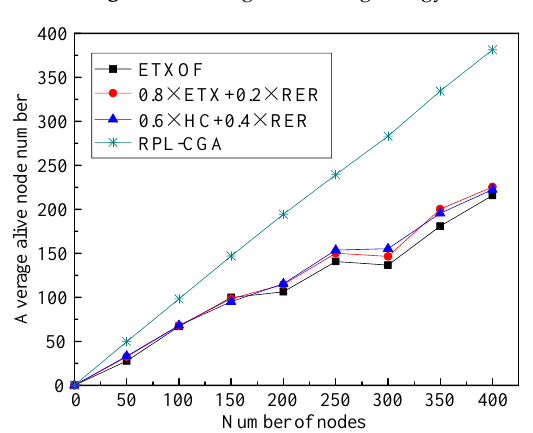
Figure 6. Average alive node number.